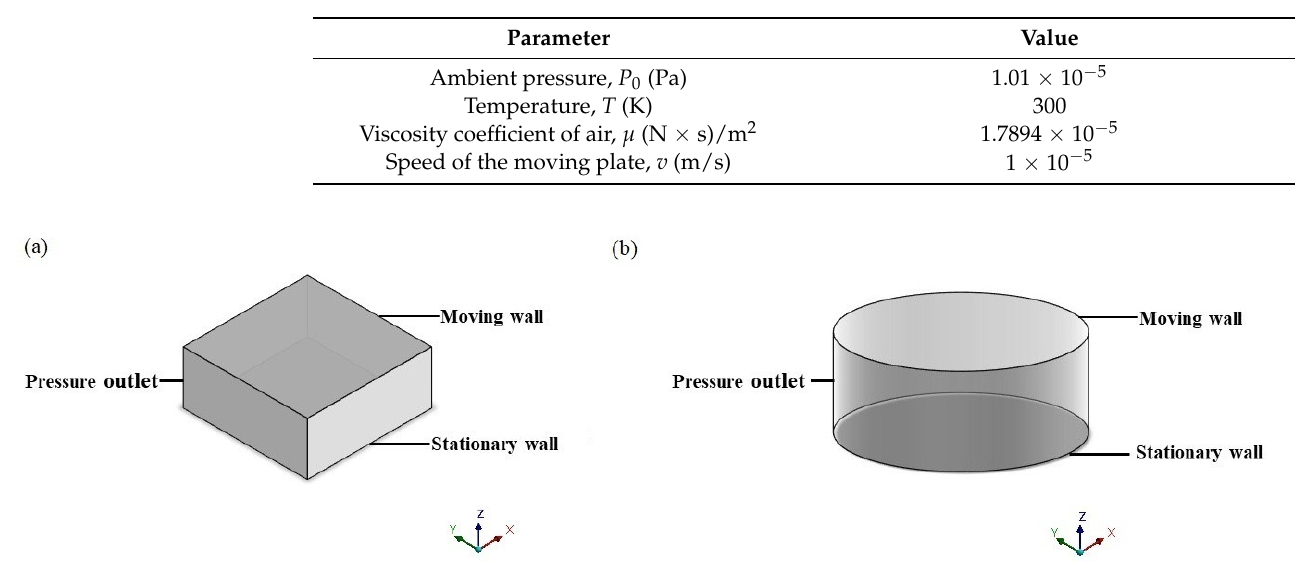
Table 1. Simulation parameters setting.